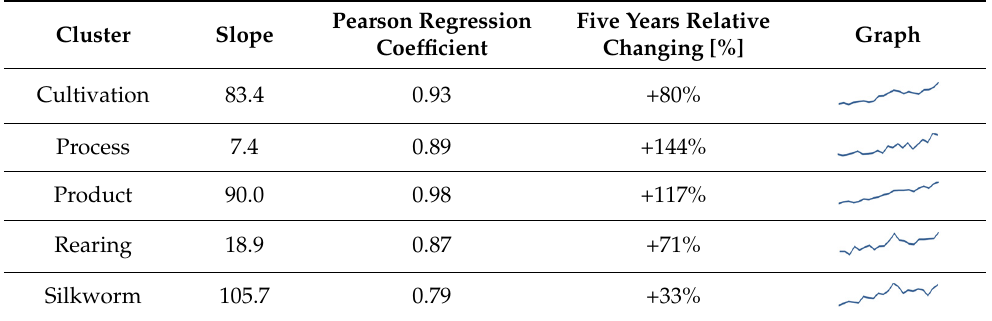
Table 7. Analysis of cluster considering their slope, Pearson regression coefficient, and their relative increment in the past five years.